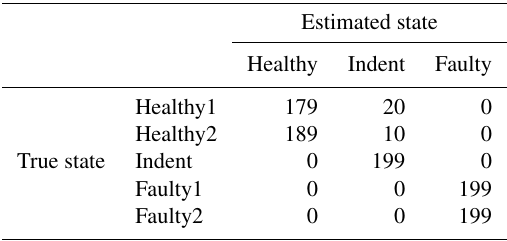
Table 11. Confusion matrix for 3000rpm PCB data and the top three features, classifier trained with ramp-up data, with an addi- tional offset in the steady-state validation